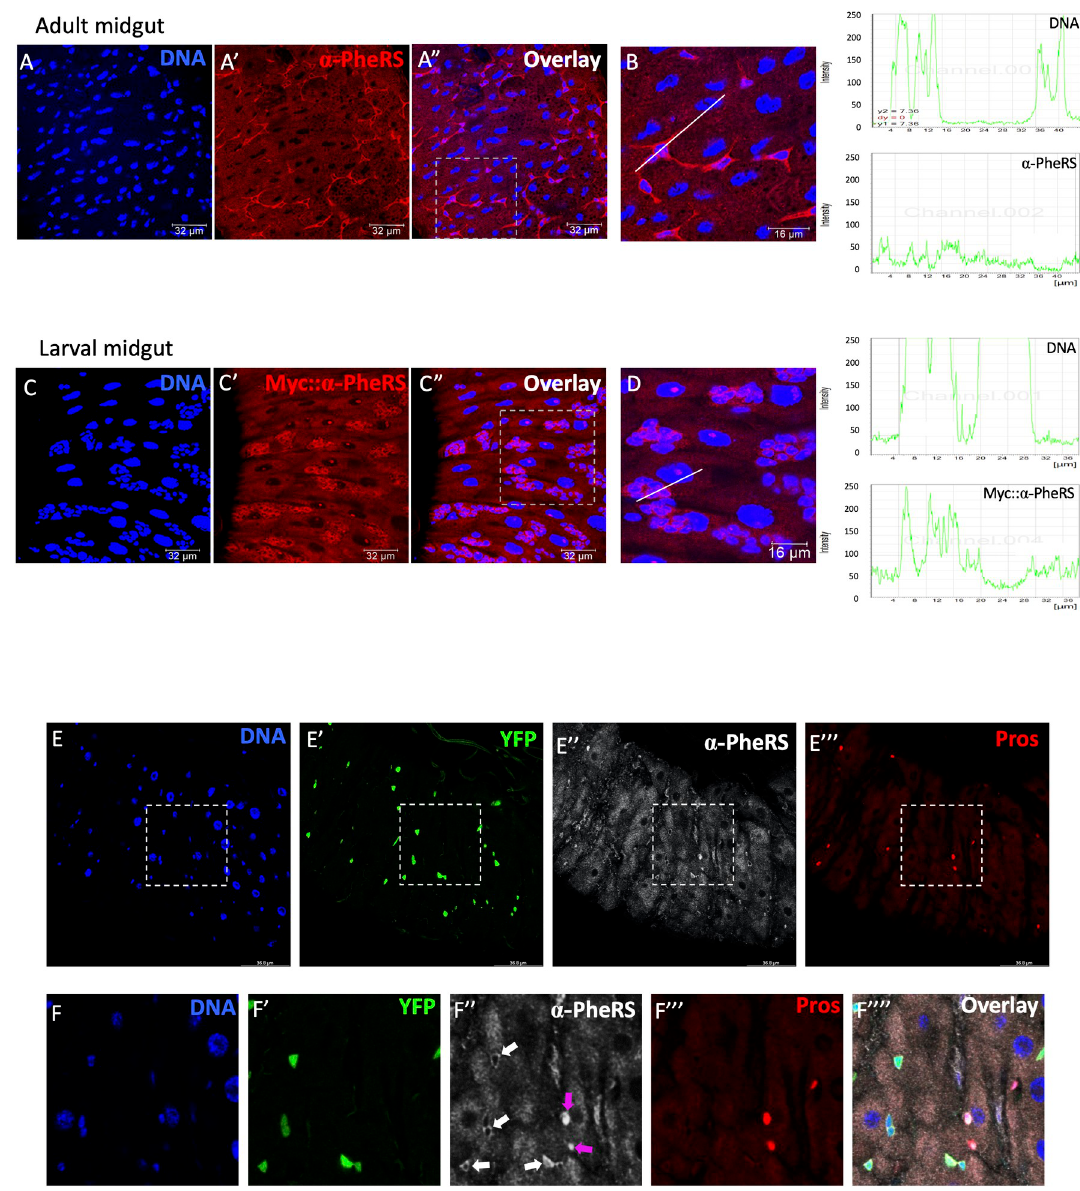
Fig 1. α -PheRS is enriched in Drosophila progenitor and enteroendocrine cells. (A-A”, B, C-C”, D) Endogenous α -PheRS accumulation is higher in small, diploid progenitor cells in wild-type adult and larval midguts. Signal intensity values in the graphs (right column) were measured from left to right along the lines in B and D. (E-F””) The esg-Gal4 , UAS-2XEYFP;tub-Gal80 ts (= esg ts ) system and Prospero staining, respectively, were used to label progenitor and enteroendocrine cells, respectively. Animals were mated at 18˚C and adults of the required genotypes were collected and shifted to 29˚C to inactivate Gal80 ts . Adult midguts were dissected from female flies after 5 days of